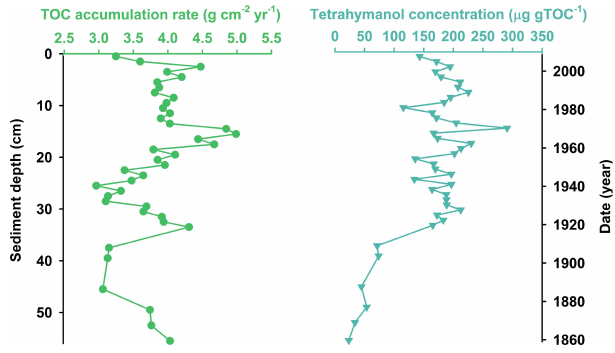
Fig. 17. Profiles of TOC accumulation rate and tetrahymanol con- centrations in Lake Rotsee as a function of sediment depth (cm) and date (year).